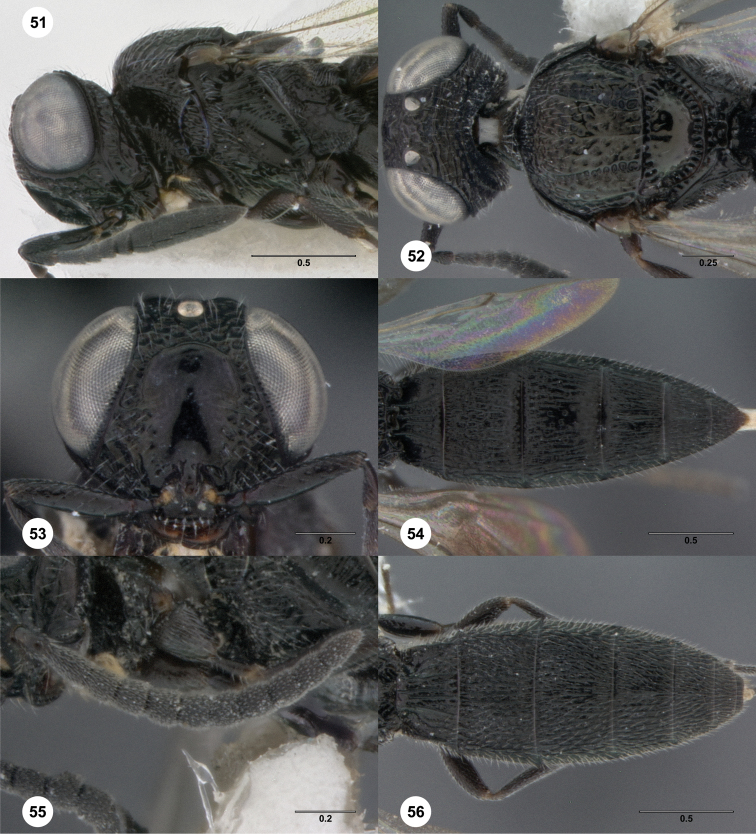
Oxyscelio concoloripes (Dodd), female (OSUC 439387) 51 Head and mesosoma, lateral view. Female (OSUC 439399) 52 Head and mesosoma, dorsal view 53 Head, anterior view 54 Metasoma, dorsal view. Male (OSUC 439527) 55 Antenna 56 Metasoma, dorsal view. Morphbank37